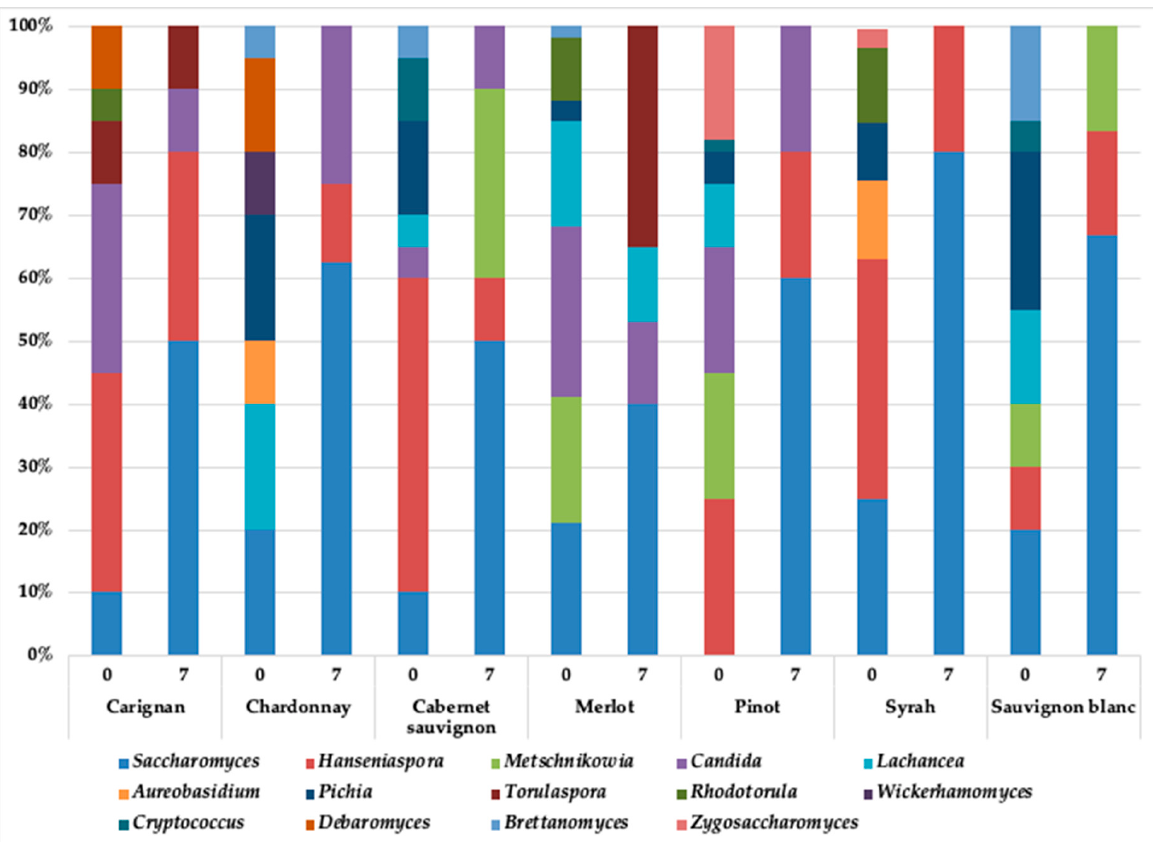
Figure 2. Results of the ITS gene amplicon sequencing data analysis for fresh and fermented grape juice samples collected on days 0 and 7 of fermentation. Data are presented by grape cultivar.